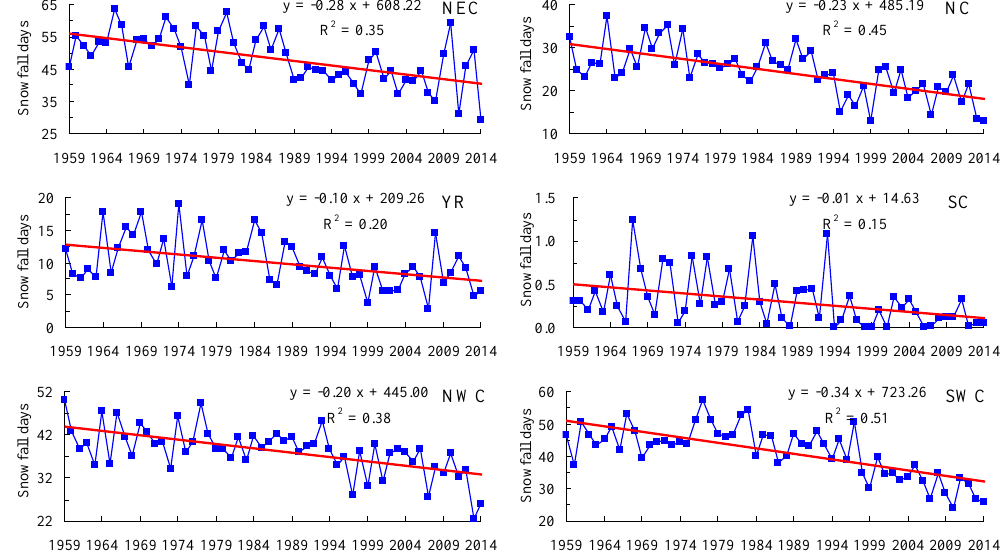
Figure 2. Variations of annual average snowfall days in six regions of China during 1959–2014. (The blue lines are the annual value and the red lines are the linear trend, the same as